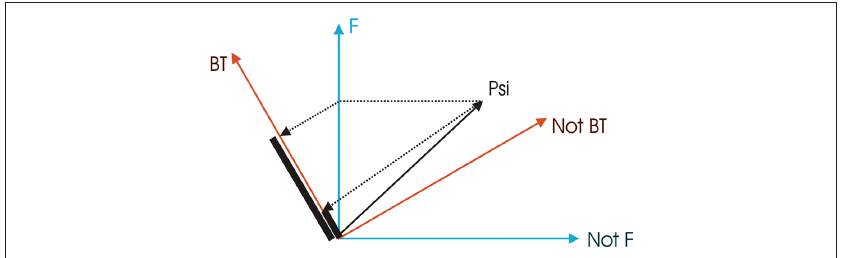
Figure 1 | A simple explanation for how QP theory can account for the conjunction